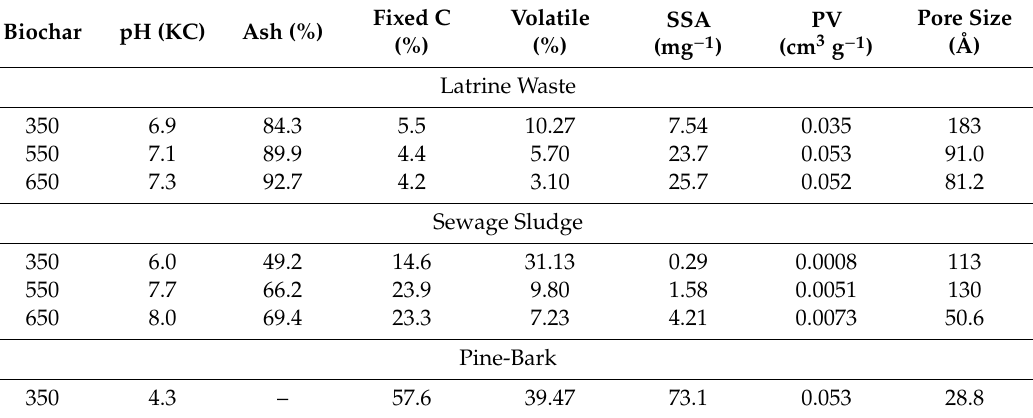
Table 6. Selected physicochemical properties of biochars used in this study.